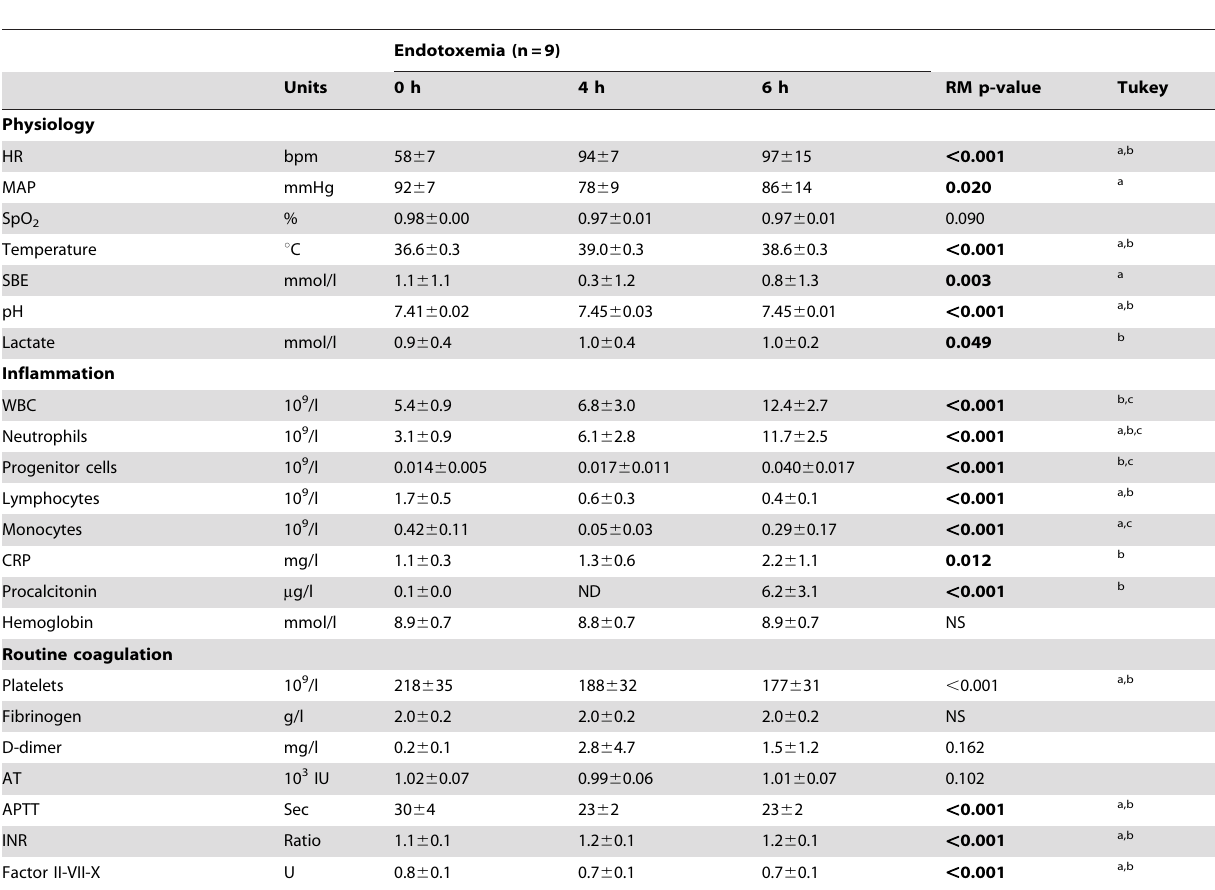
Table 1. Physiology and standard biochemistry in nine healthy volunteers before (0 h), during (4 h) and after (6 h) induction of experimental endotoxemia by means of a 4 h 0.5 ng/kg/hour